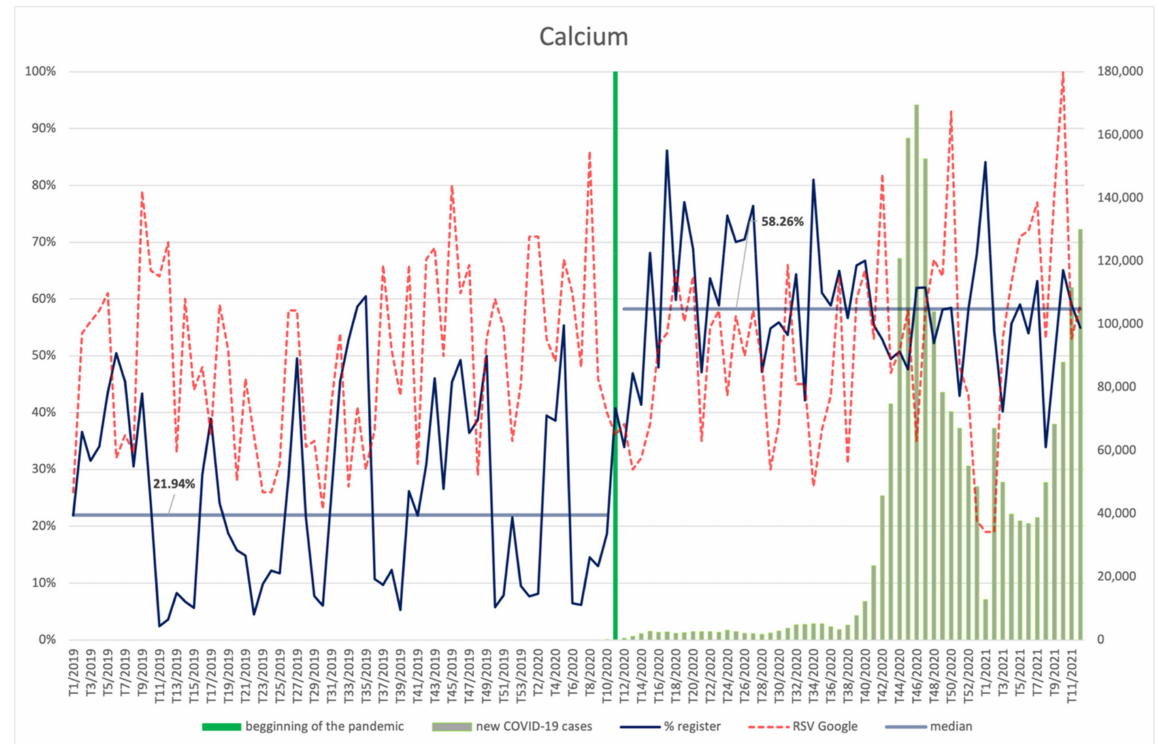
Figure 17. Comparison between the number of new registrations of products containing calcium, the number of COVID-19 cases, and the frequency of search for information on the ingredient in the Google browser.